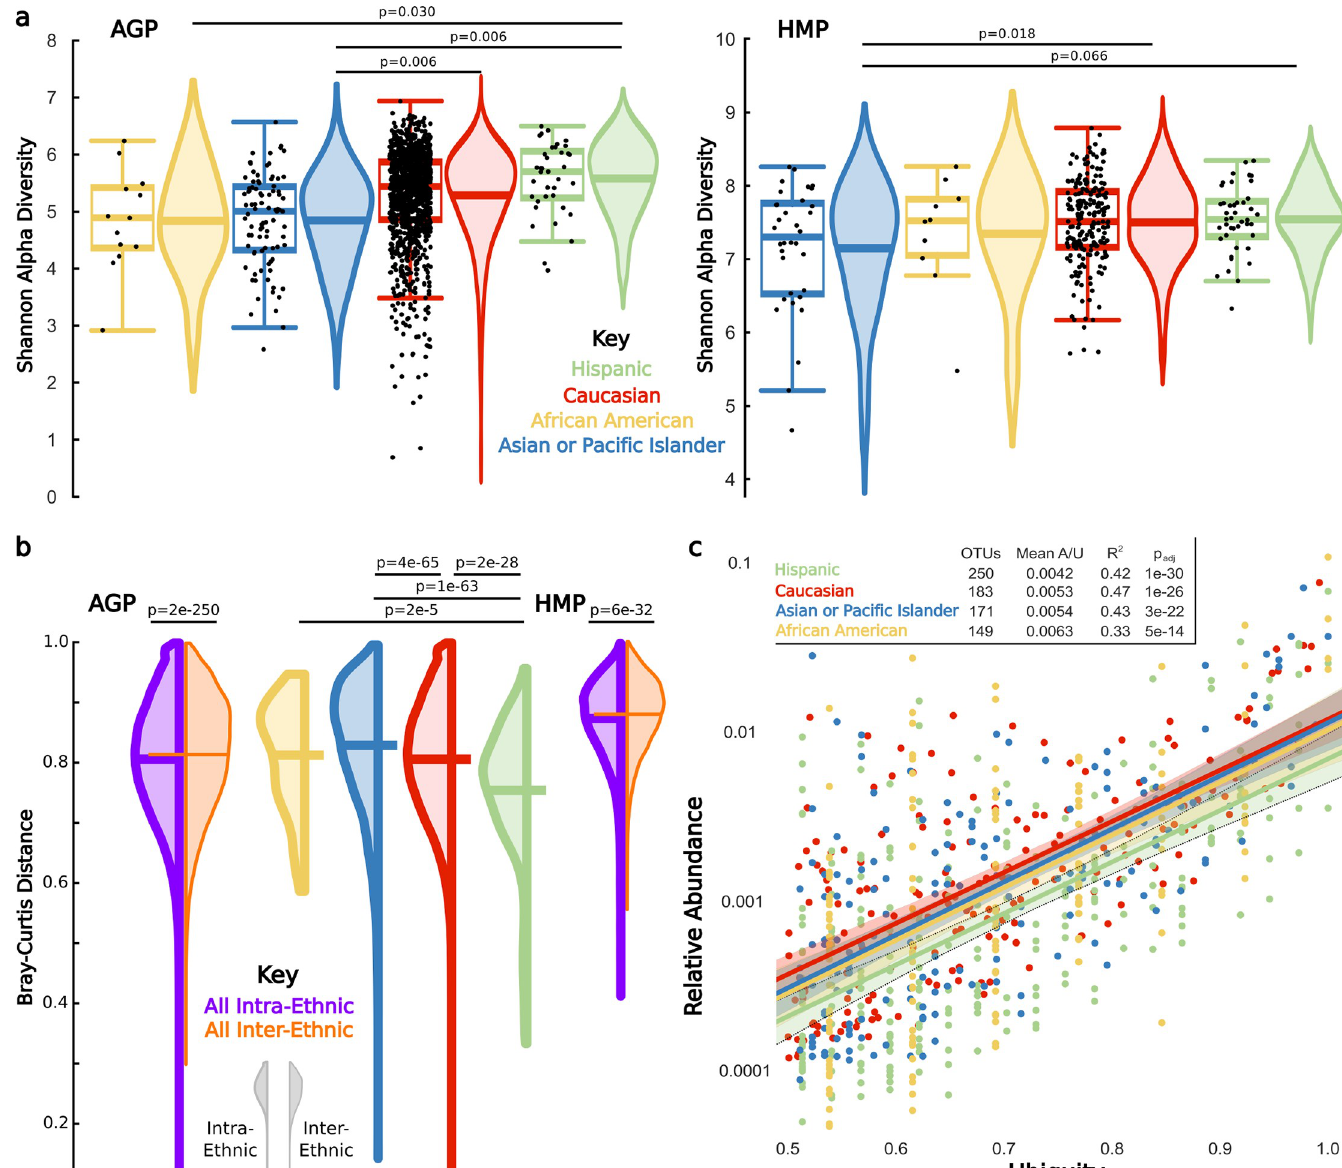
Fig 2. Ethnicity associates with diversity and composition of the gut microbiota. (A) Center lines of each boxplot depict the median by which ethnicities were ranked from low (left) to high (right); the lower and upper ends of each box represent the 25th and 75th percentiles, respectively; whiskers denote the 1.5 interquartile range; and black dots represent individual samples. Lines in the middle of violin plots depict the mean, and p -values are Bonferroni corrected within each data set. (B) Left extending violin plots represent intraethnic distances for each ethnicity, and right extending violin plots depict all interethnic distances. Center lines depict the mean beta diversity. Significance bars above violin plots depict Bonferroni corrected pairwise Mann–Whitney U comparisons of the intra-intra- and intra-interethnic distances. (C) Within each ethnicity, OTUs shared by at least 50% of samples. Colored lines represent a robust ordinary least squares regression within OTUs of each ethnicity, shaded regions represent the 95% confidence interval, R 2 denotes the regression correlation, the OTUs column indicates the number of OTUs with > 50% ubiquity for that ethnicity, Mean A/U is the average abundance/ubiquity ratio, and the p adj is the regression significance adjusted and Bonferroni corrected for the number of ethnicities. Data available at https://github.com/awbrooks19/microbiota_and_ethnicity. OTU, operational taxonomic unit. https://doi.org/10.1371/journal.pbio.2006842.g002 (S4A and S4B Table). Finally, we repeat analyses across beta metrics and rarefaction depths using only the average distance of each individual to all individuals from the ethnicity to which they are compared (S4C and S4D Table).